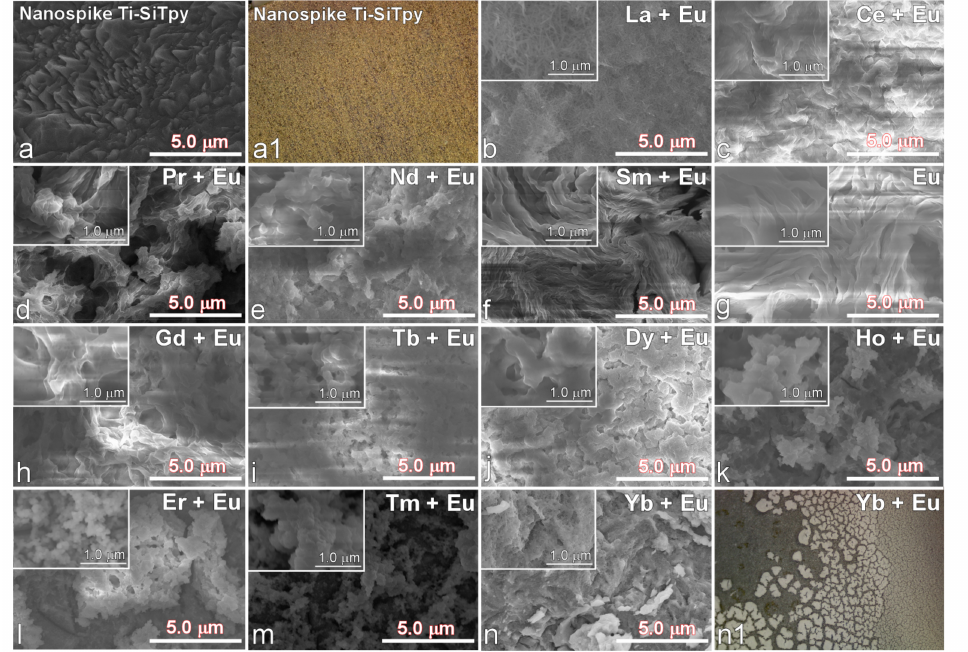
Figure 2. SEM (scanning electron microscope) images ( a – n ) of electrodeposited mixed Ln over TiNS- SiTpy electrodes in a 5 mM Eu (III) + 5 mM Ln (III)/0.1 M NaClO 4 electrolyte at an applied potential observed in the corresponding CV, and selected optical microscope images (300 × ) for TiNS-SiTpy ( a1 ) and electrodeposited mixed Yb + Eu on a nanospike electrode ( n1 ), and insets show the magnified image of the corresponding SEM